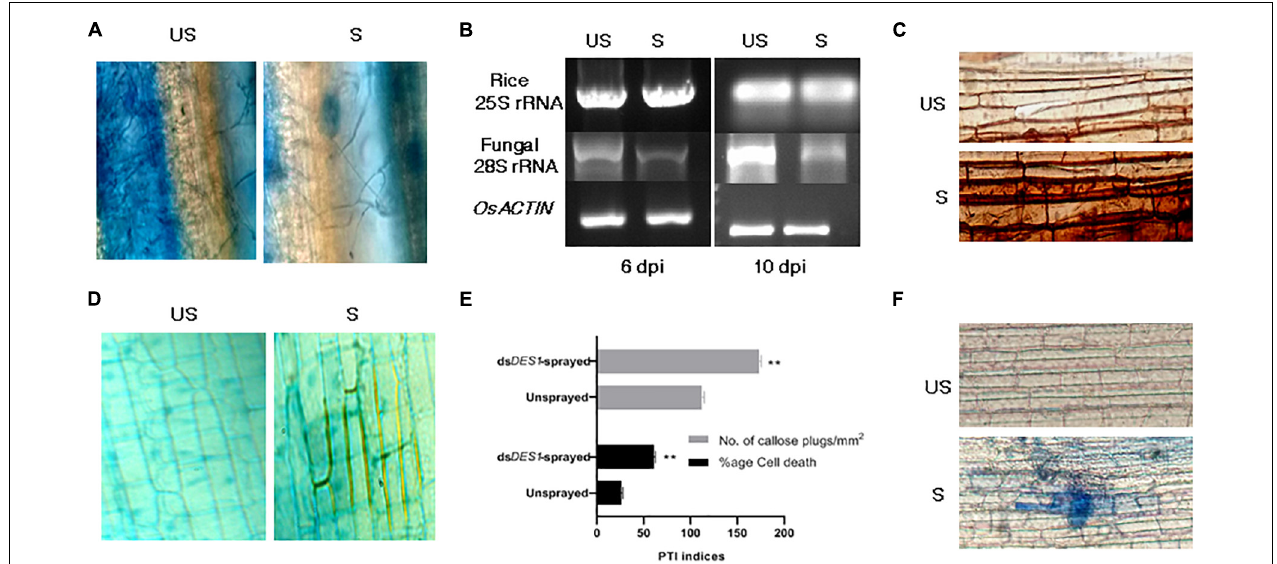
FIGURE 7 | Evaluation of fungal growth and defense parameters of pathogen-associated molecular pattern (PAMP)-triggered immunity (PTI). (A) Qualitative assessment of fungal growth. Lactophenol blue staining of fungal mycelia observed in infection lesions from ds DES1 -sprayed and unsprayed leaves. (B) Semi-quantitative reverse transcriptase PCR for Mo 28S rRNA that is representative of fungal biomass in sprayed and unsprayed infected leaves. While Os 25S rRNA was the growth control from rice that was used for comparison, MoACTIN served as the internal control. (C) DAB assay. Host-derived ROS generation in infected cells from ds DES1 -sprayed and unsprayed leaf-sheaths was visualized by DAB staining. (D) Secondary wall deposition around primary infected cells and their neighbors to curb disease progression via aniline blue staining. (E) Callose plug formation (aniline blue staining) and percentage of cell death (trypan blue staining) in ds DES1 -sprayed and unsprayed infected rice cells. (F) Trypan blue staining of sprayed and unsprayed sheath cells undergoing necrosis. The error bars represent standard deviation, and ** denotes statistical significance at the P ≤ 0.01 level.